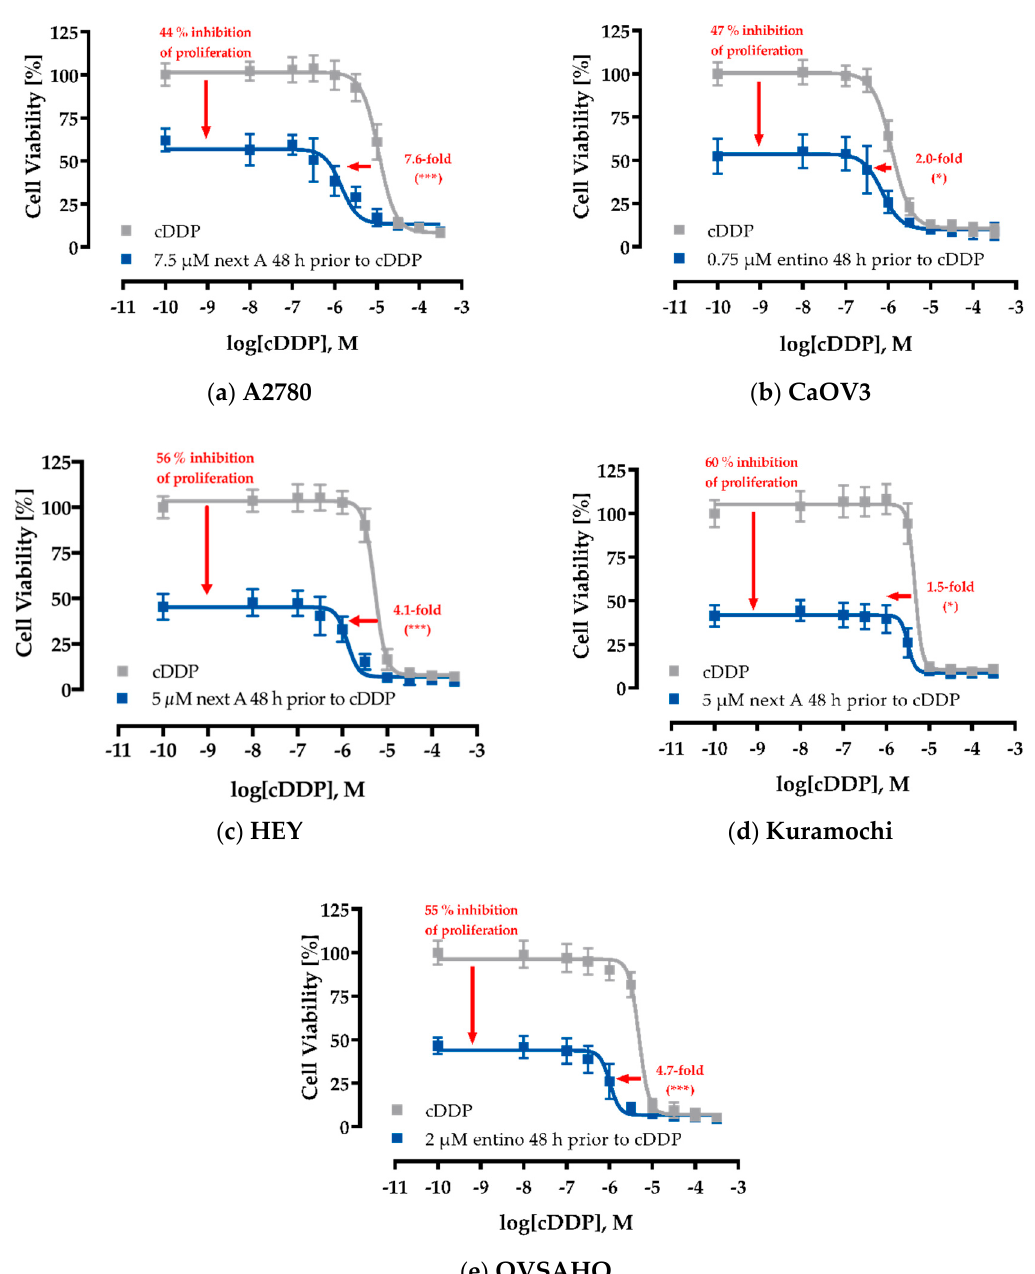
Figure 3. HDACi pretreatment enhances the cytotoxic effects of cisplatin. A2780 ( a ), CaOV3 ( b ), HEY ( c ), Kuramochi ( d ), and OVSAHO ( e ) were pretreated with the indicated HDACi 48 h prior to cisplatin (cDDP) administration. After another 72 h, IC 50 -values were determined by MTT assay. Data shown are normalized to vehicle control and mean ± SD of at least three experiments each carried out in triplicates. The vertical arrows show the antiproliferative effects of HDACi in the absence of cisplatin and the horizontal arrows show the shifts of the IC 50 -values of cisplatin (absence and presence of HDACi). Statistical analysis was performed using t-test. Levels of significance: ns ( p > 0.05); * ( p ≤ 0.05); ** ( p ≤ 0.01); *** ( p ≤ 0.001).